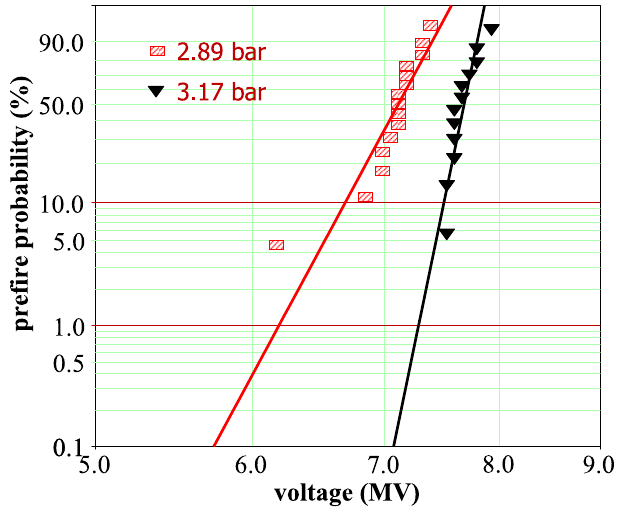
FIG. 14. (Color) The laser-trigger system for the refurbished Z